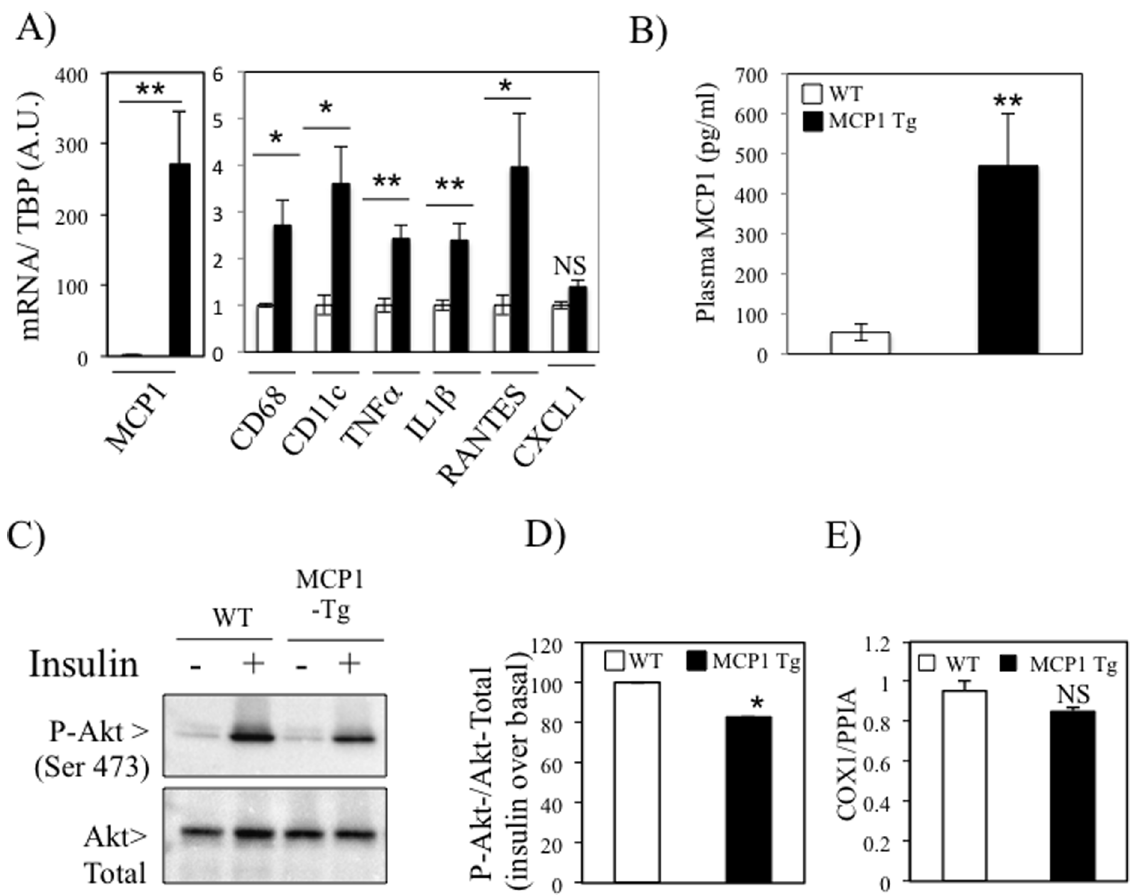
Figure 5. Skeletal muscle overexpression of MCP1 induces local inflammation and alters insulin signaling and glucose metabolism invivo . A) QPCR analyses of MCP1, CD68, CD11c, TNF a , IL1 b , RANTES and CXCL1 expression were performed on quadriceps. C–D) Ex-vivo insulin signaling assay were performed on freshly isolated gastrocnemius. The histogram (D) represents the fold response to insulin on Akt phosphroylation in Wild-Type (WT) and MCK-MCP1-Tg mice. E) Genomic mitochondrial DNA was evaluated by qPCR in skeletal muscle of WT and transgenic mice. * stands for P , 0.05 and ** for P , 0.01; n=6.